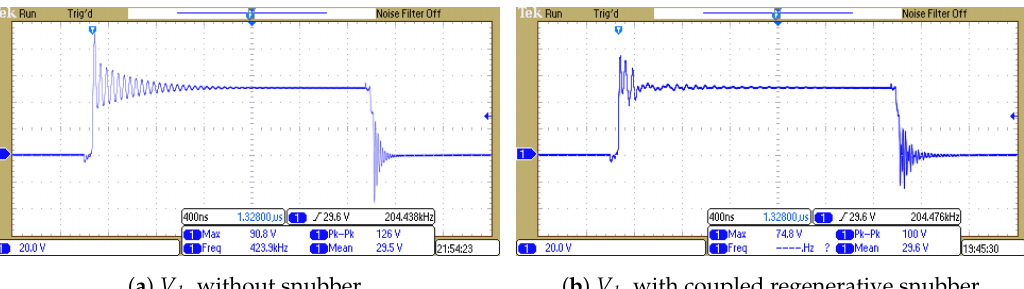
Figure 12. Prototype for SEPIC converter.